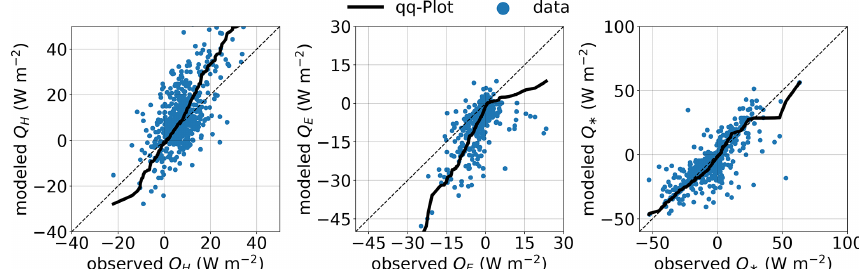
Figure 7. Comparison between daily means of modeled and observed Q H , Q E , and Q ∗ for all three study winters. Overlain is a quantile– quantile plot.